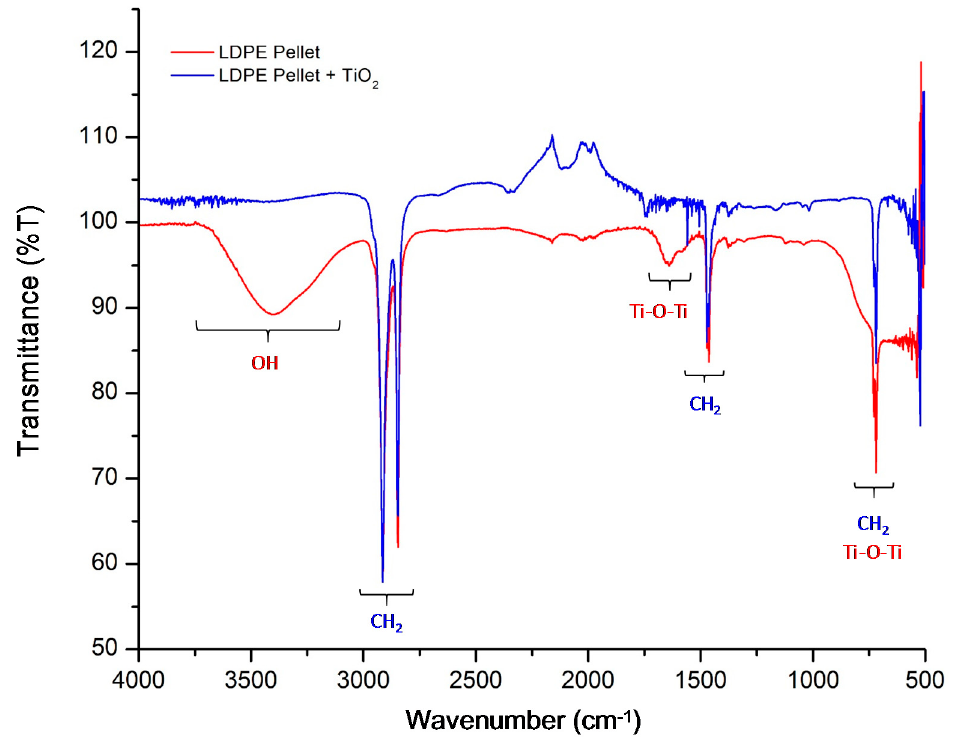
Figure 4. Fourier Transform infrared spectroscopy equipped with attenuated total reflectance unit (FTIR-ATR) spectra of bare pellet (blue line) and TiO 2 -LDPE pellet (red line).